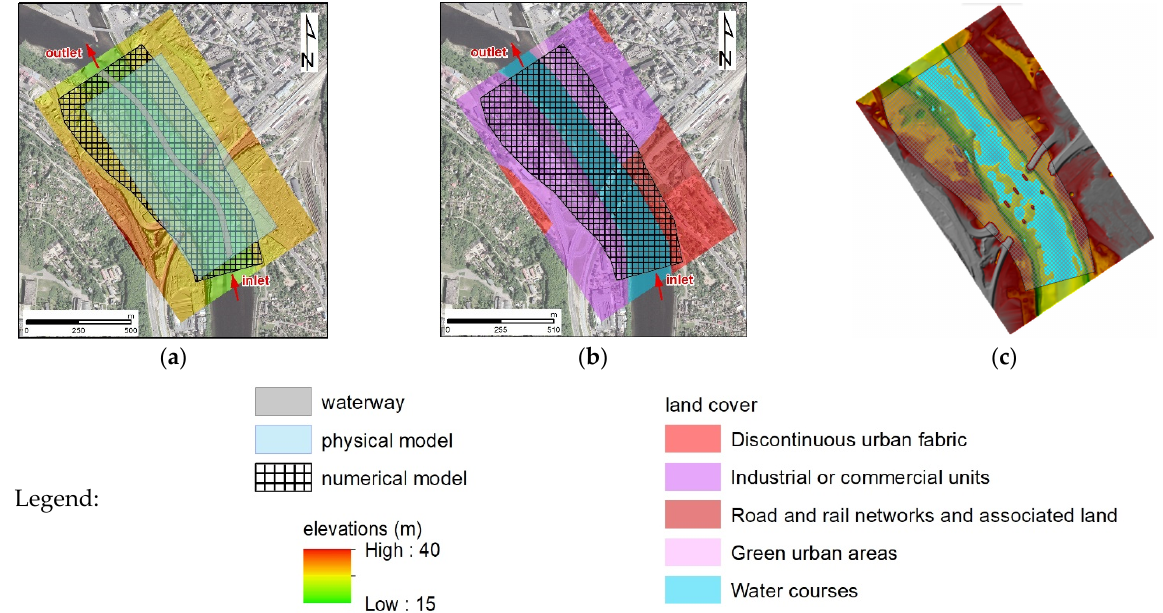
Figure 6. Geometrical properties of the numerical model: ( a ) the modeled area with additional elements, ( b ) the land cover from Corine 2018 database, ( c ) the modeled area in HEC-RAS.